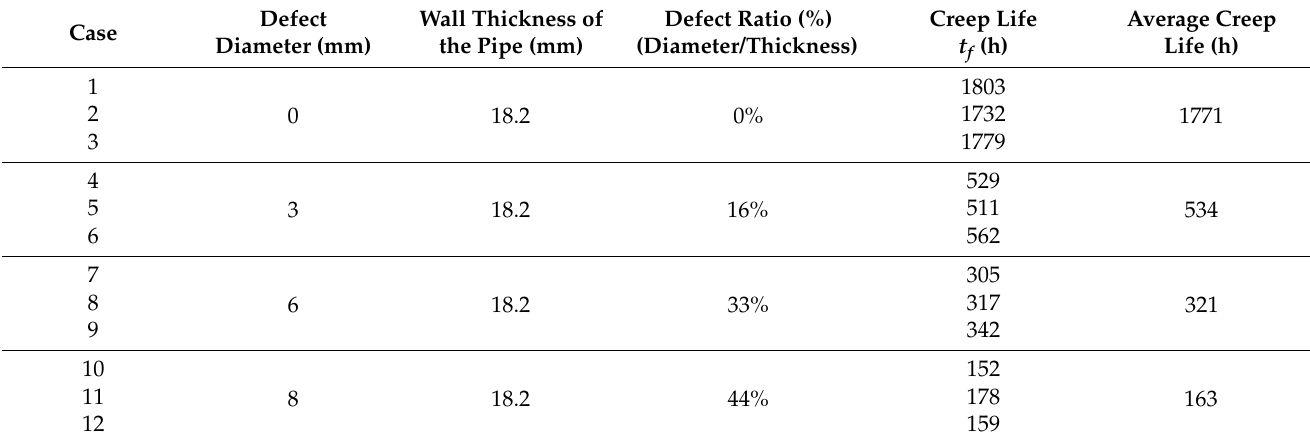
Figure 2. SEM micrographs of the base material and welded joint of HDPE. Table 2. The defect diameter, wall thickness, defect ratio and creep life of the specimens.